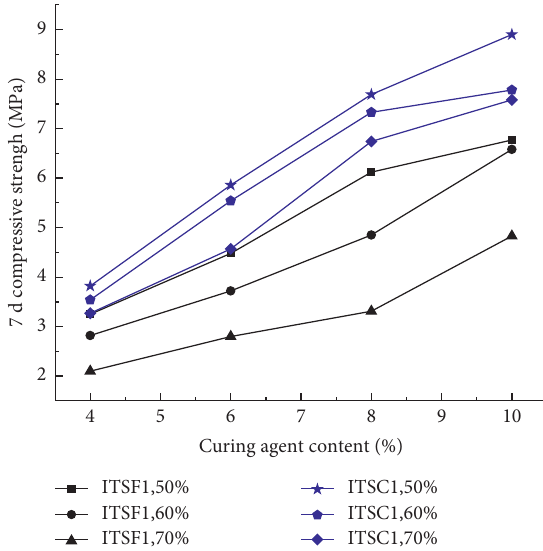
Figure 7: 7d unconfined compressive test results in different curing agent